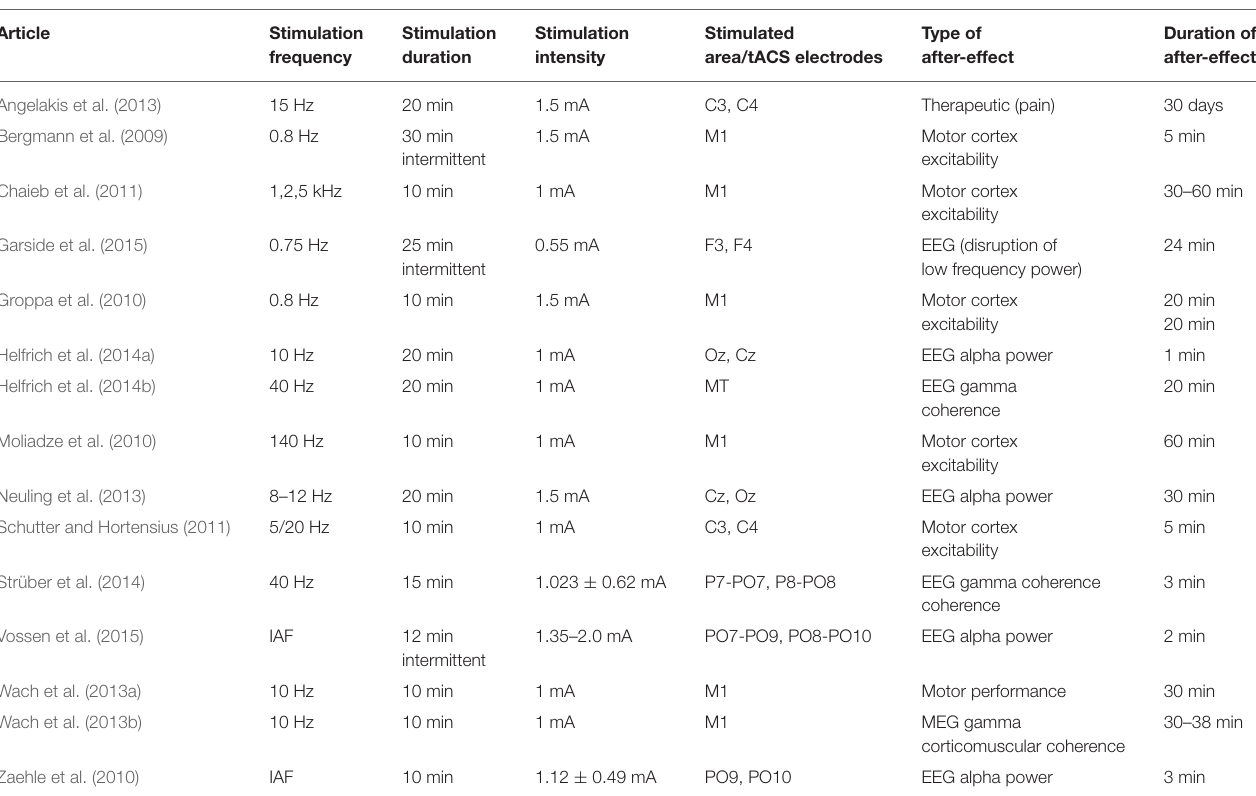
TABLE 1 | Examples of human tACS studies demonstrating